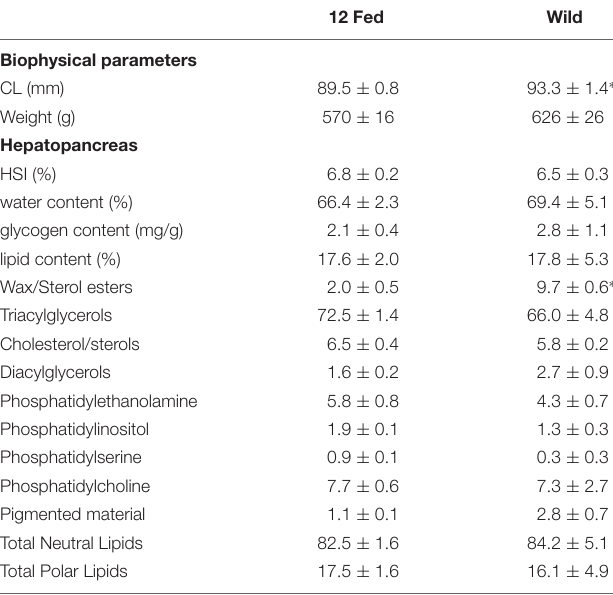
TABLE 2 | Comparison of the experimental group fed and kept at 12 ◦ C ( n = 9) with a reference group of H. gammarus captured from the wild on the final day of sampling ( n =